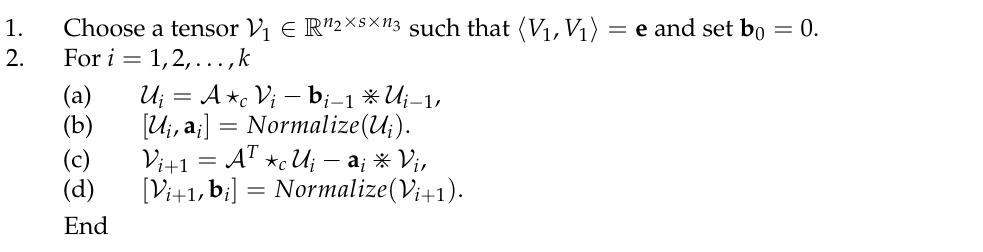
Algorithm 5 The Tensor Tube Global Golub–Kahan algorithm